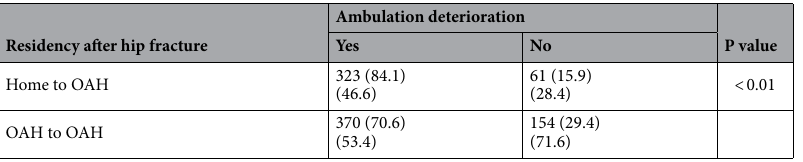
Table 3. Relationship between ambulation deterioration and the residency after geriatric hip fracture after hip fracture. Odds ratio = 1.19 (95% CI: 1.11,